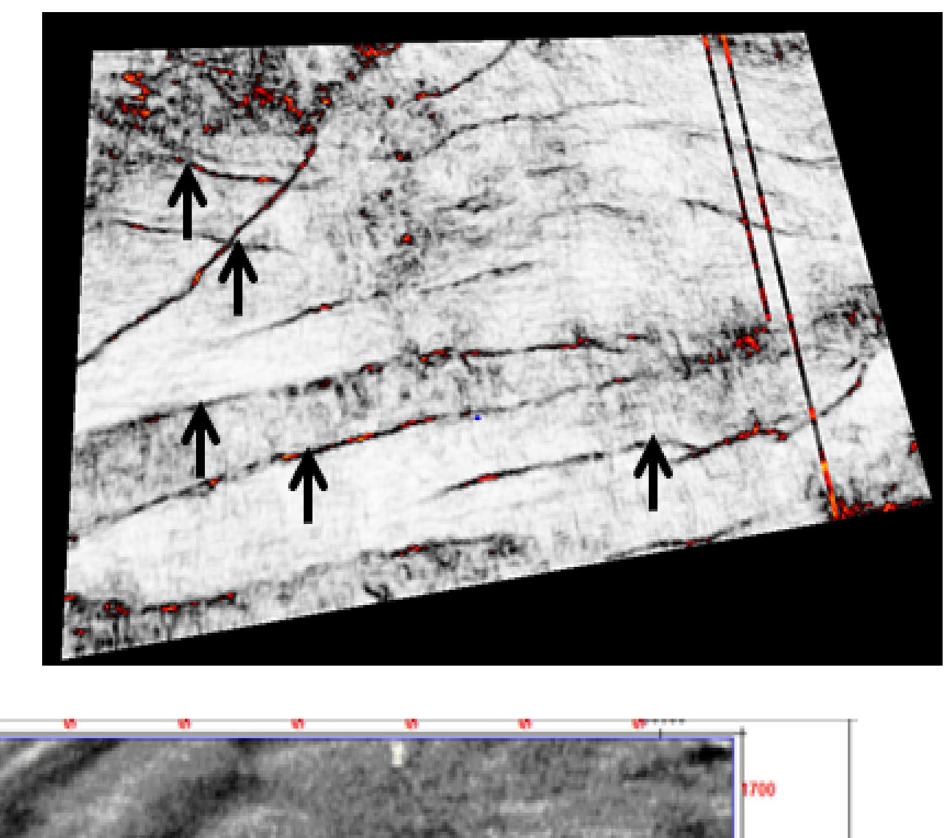
Fig. 7 Variance attribute. This figure is a variance attribute that shows a better picked fault lines, when compared with the faults that were picked on the normal seismic amplitude